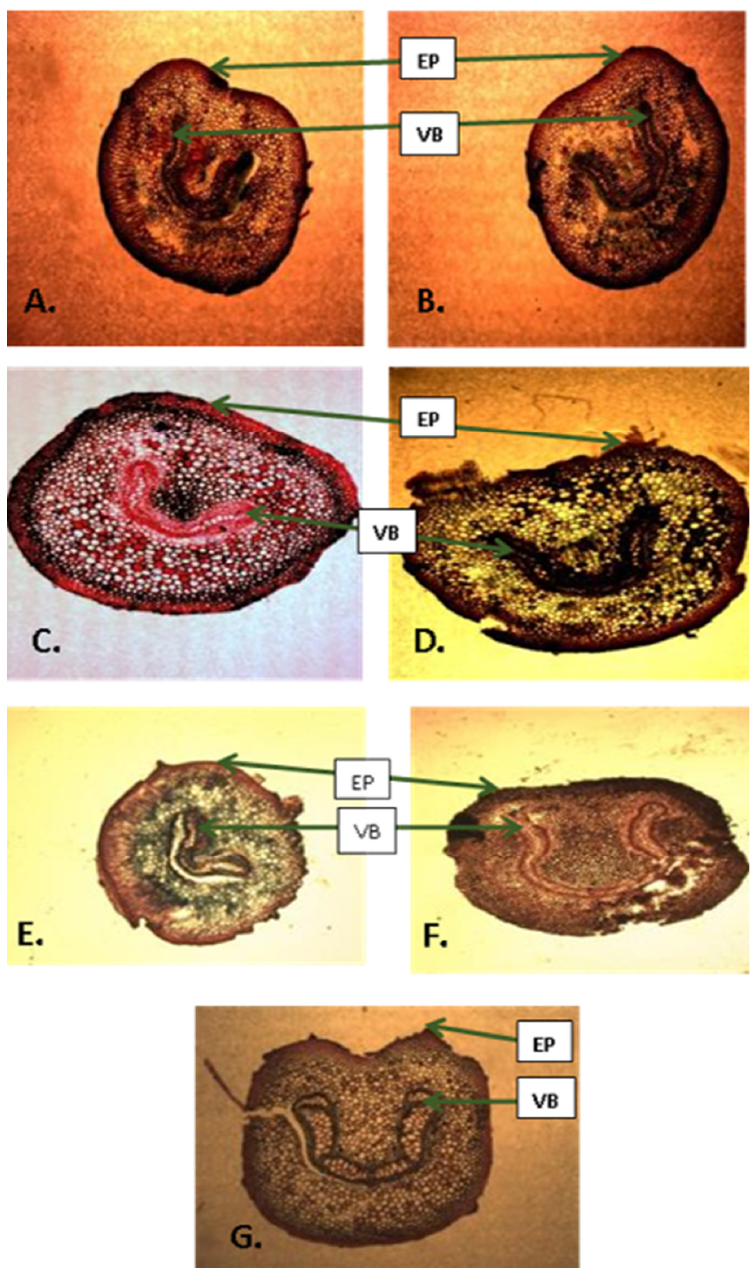
Figure 3. Transverse sections of distal regions of stipes showing outlines in seven species of Pteris